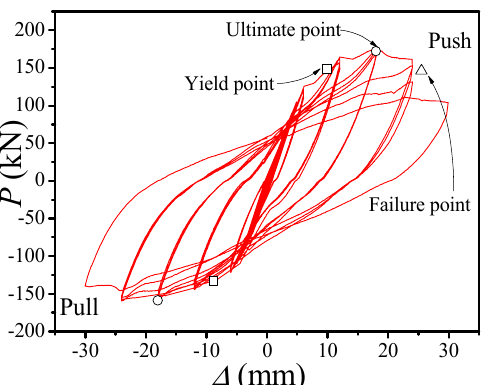
Figure 9. Hysteretic curves of the recycled aggregate concrete filled circular steel tube (RACFCST) frame.